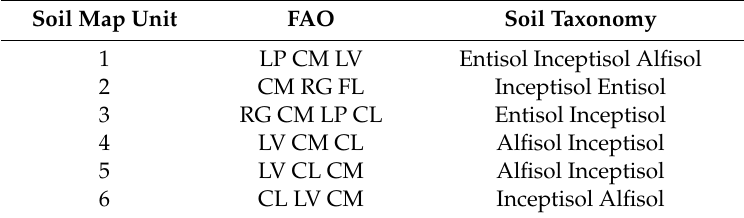
Table 3. Soil map units and equivalence between FAO and Soil